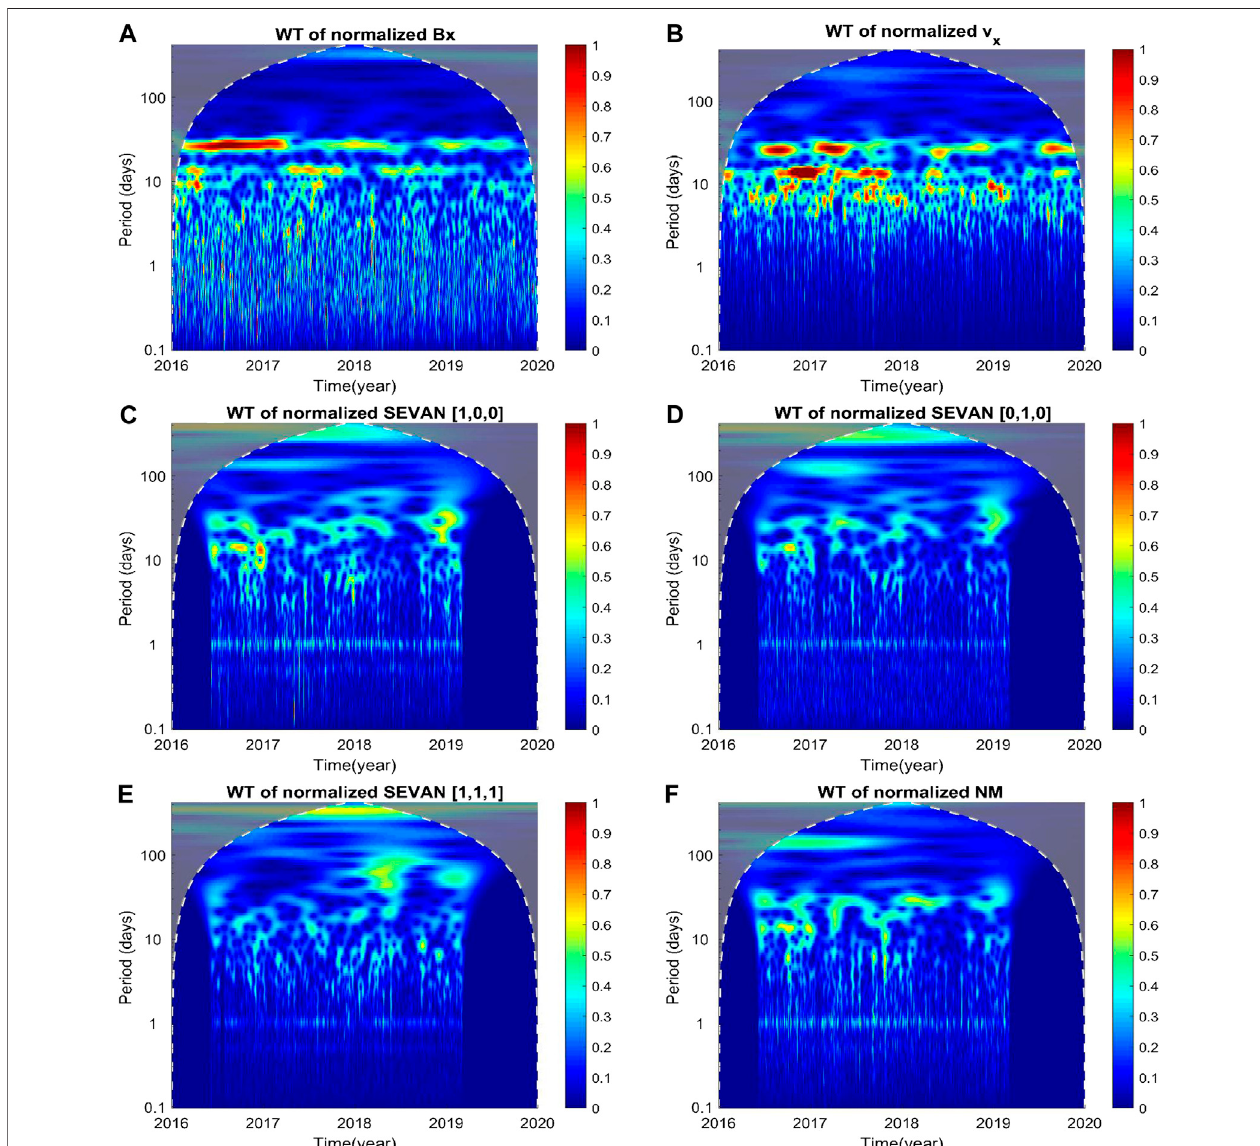
FIGURE 6 | Wavelet transform of (A) B x component of the HMF, (B) v x component of SW velocity, and (C – F) normalized pressure-corrected counts measured using SEVAN combinations [1,0,0], [0,1,0], and [1,1,1] and the NM, respectively, on LS.